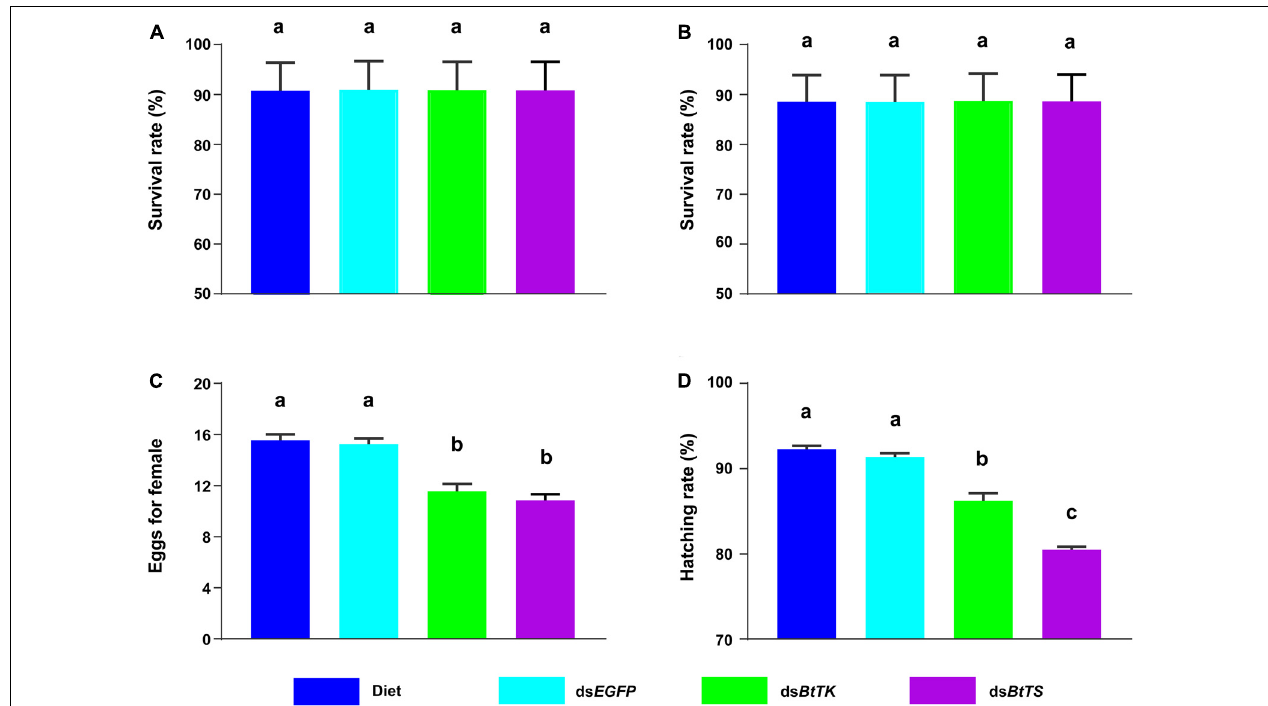
FIGURE 6 | Effects of BtTK and BtTS silencing on B. tabaci MED. (A) Survival of B. tabaci MED adults upon treatment with dsRNA or artificial diet for 2 days. (B) Survival of B. tabaci MED adults after treatment with dsRNA or artificial diet for 4 days. (C) Effects of dsRNA or artificial diet on the egg production of B. tabaci females. (D) Effects of dsRNA or artificial diet on the hatchability of B. tabaci offspring. The values shown are the means and standard errors, and the different letters indicate treatment differences at p < 0.05 (one-way ANOVA with Tukey’s